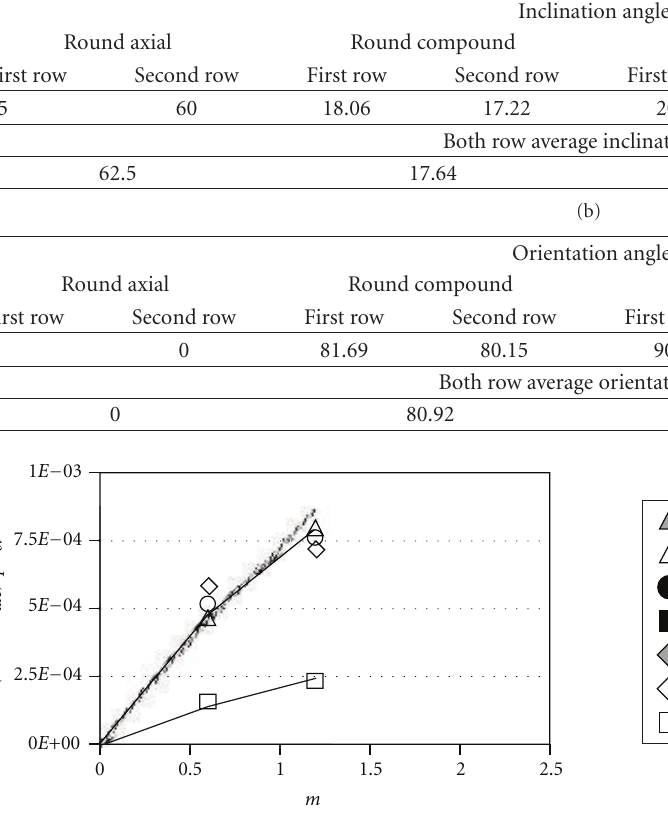
Figure 25: Normalized Integrated Aerodynamic Loss values for di ff erent hole configurations for film injection from both rows of holes, for cambered vanes with film cooling [55]. Symbols are defined in Figure 24. Lines are determined using (17) and C 1 values from Table 3.